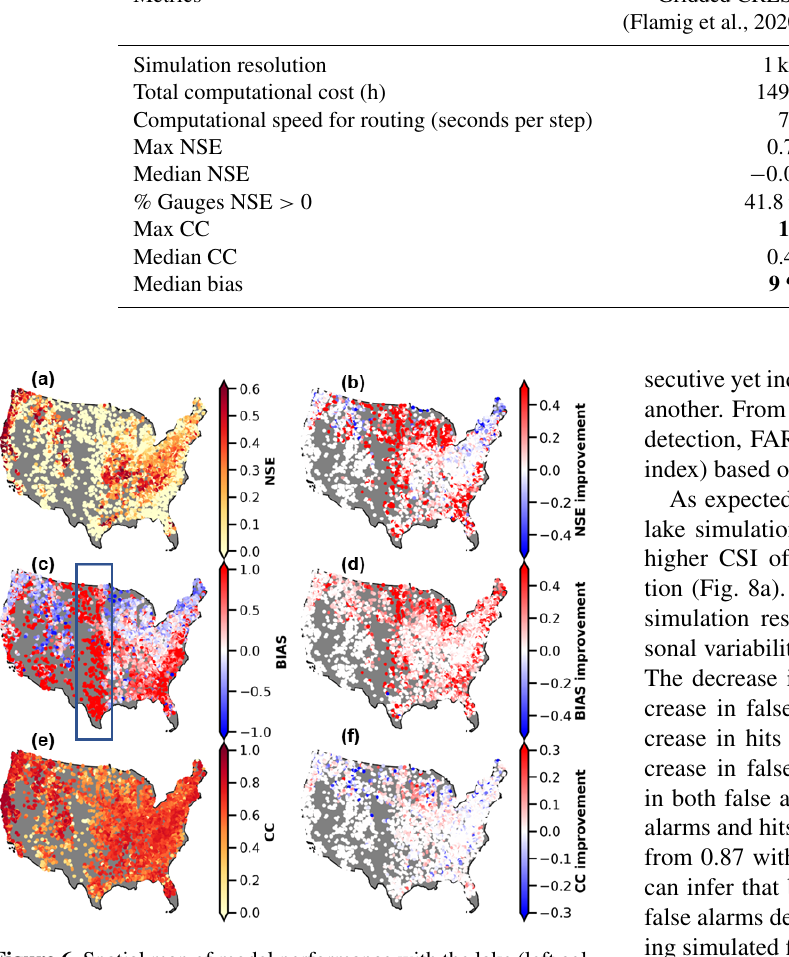
Figure 6. Spatial map of model performance with the lake (left col- umn) and the difference between with lake simulation and without lake simulation (right column). (a) NSE scores; (b) NSE differences (results with lake minus results without lake); (c) bias; (d) bias dif- ference; (c) CC (correlation coefficient); (f) CC difference. The blue box in (c) highlights the region where high positive bias is